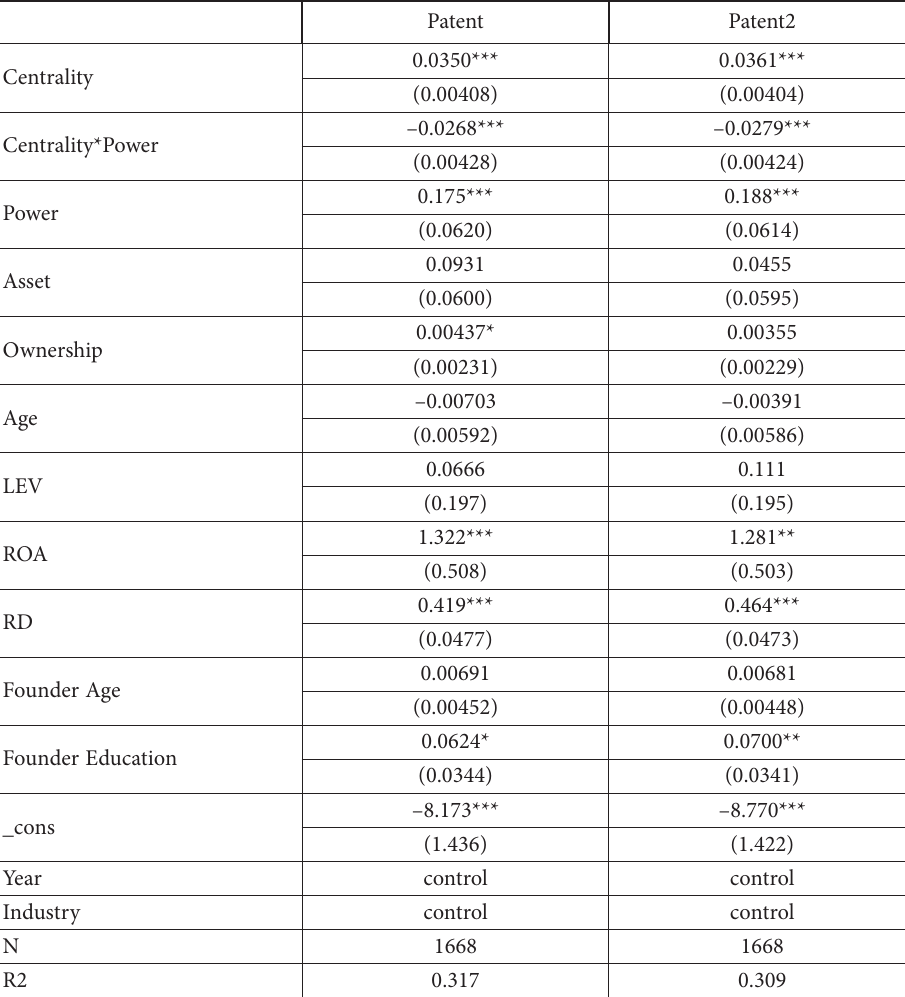
Table 8. Analysis of value improvement